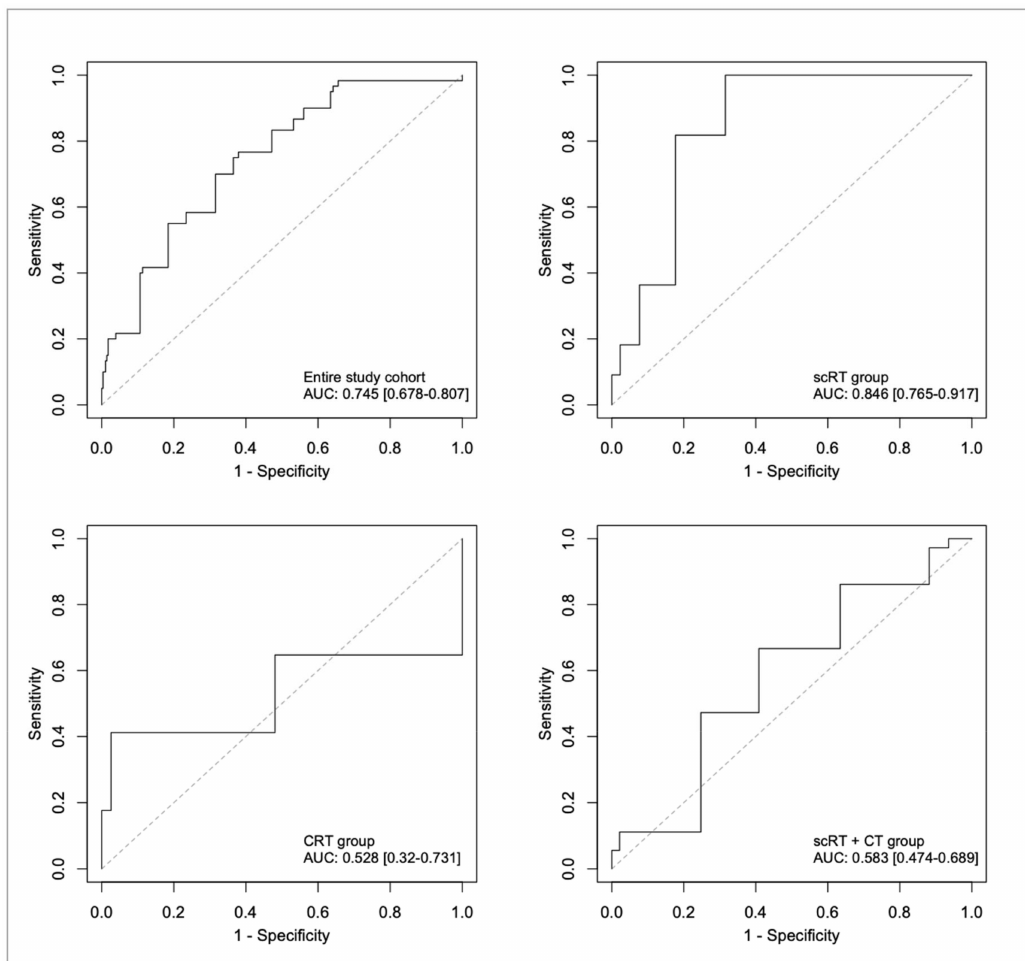
Figure 2. Receiver operating characteristic (ROC) curves of the four logistic regression models (solid lines) and reference ROC curves of the uninformative random classifier (dashed lines), annotated with area under curve (AUC) values and their 95% confidence intervals. (top left) Entire study cohort. (top right) scRT group. (bottom left) CRT group. (bottom right) scRT+CT group. Abbreviations: scRT = short-course radiotherapy; CRT = chemoradiotherapy; CT =